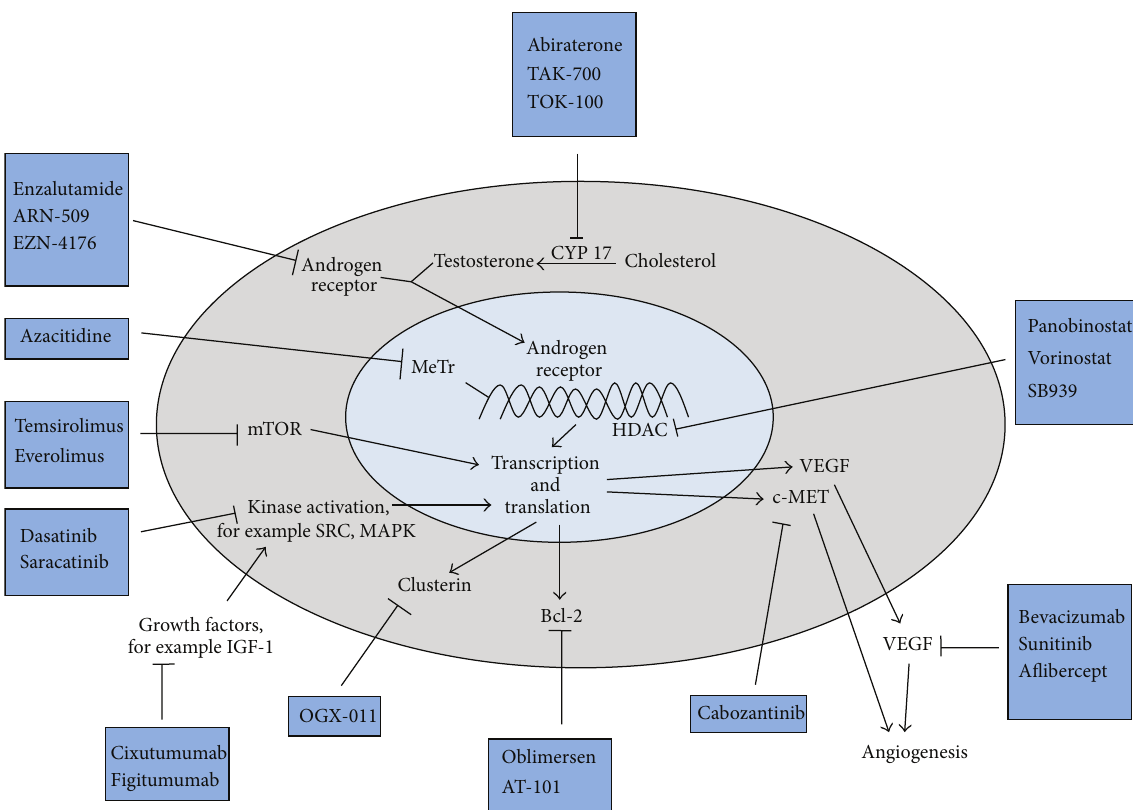
Figure 1: Androgen dependent and independent molecular pathways underlying progression of castration refractory prostate cancer and drugs targeting those pathways. CYP17: Cytochrome P450 17 alpha-hydroxylase and C17,20-lyase; mCRPC: metastatic castration refractory prostatecancer;AR:androgenreceptor;OS:overallsurvival;PFS:progressionfreesurvival;c-MET:hepatocytegrowthfactorreceptor;VEGF: vascular endothelial growth factor; MeTr: DNA methyl transferase; HDAC: histone deacetylases; Src: Src kinase; MAPK: MAP kinase; IGF-1: insulin like growth